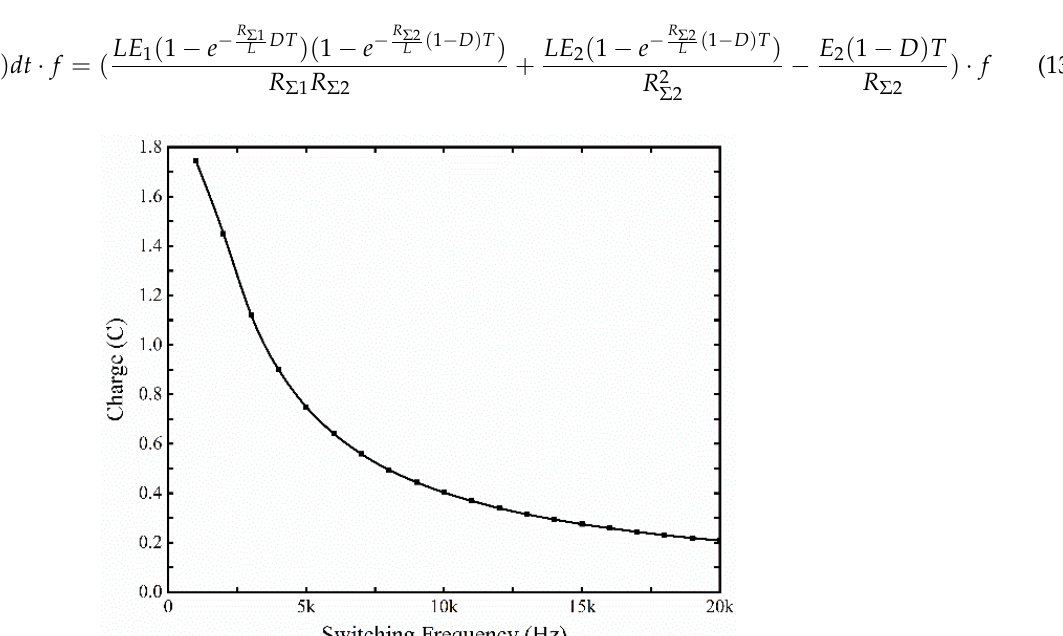
Figure 9. Variation of average equalizing current with switching frequency. Figure 9 shows the average values i 1 and i 2 of the discharging current i 1 ( t ) and the charging current i 2 ( t ) in the whole period T decreased with the increase of the switching frequency f . For comparison at the same scale, the equation for the amount of charge q 2 transferred to the target battery Cell2 per unit time can be derived as Equation (13). The amount of charge transferred to the target cell Cell2 per unit time at different switching frequencies is obtained by substituting the corresponding parameter data, as shown in Figure 10.